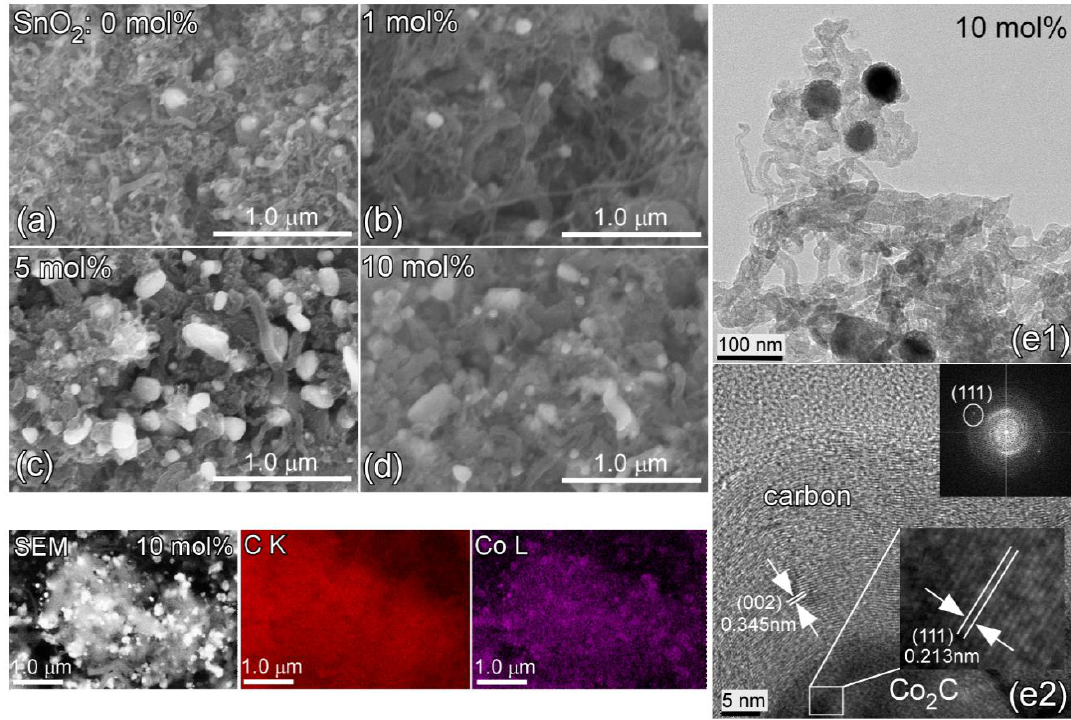
Figure 2. SEM ( a – d ), TEM ( e1 ), and HR-TEM ( e2 ) images of the prepared samples with 0, 1, 5, and 10 mol% of sacrificial SnO 2 . Elemental (C K and Co L) mapping and the corresponding SEM images for the 10 mol% sample are shown.